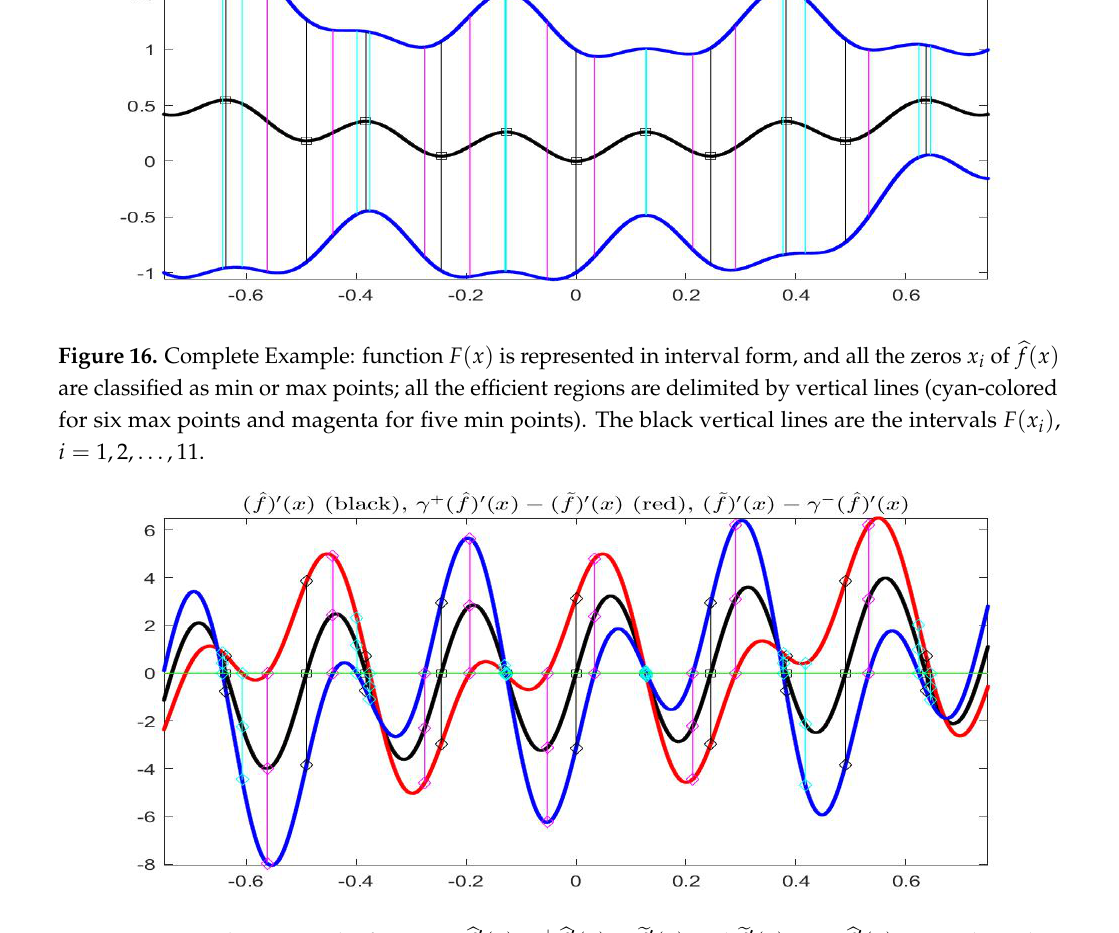
Figure 17. Complete Example: functions (cid:98) f (cid:48) ( x ) , γ + (cid:98) f (cid:48) ( x ) − (cid:101) f (cid:48) ( x ) and (cid:101) f (cid:48) ( x ) − γ − (cid:98) f (cid:48) ( x ) are evaluated at classified min and max points and the corresponding efficient frontiers are delimited by vertical lines (cyan-colored for max and magenta for min points).